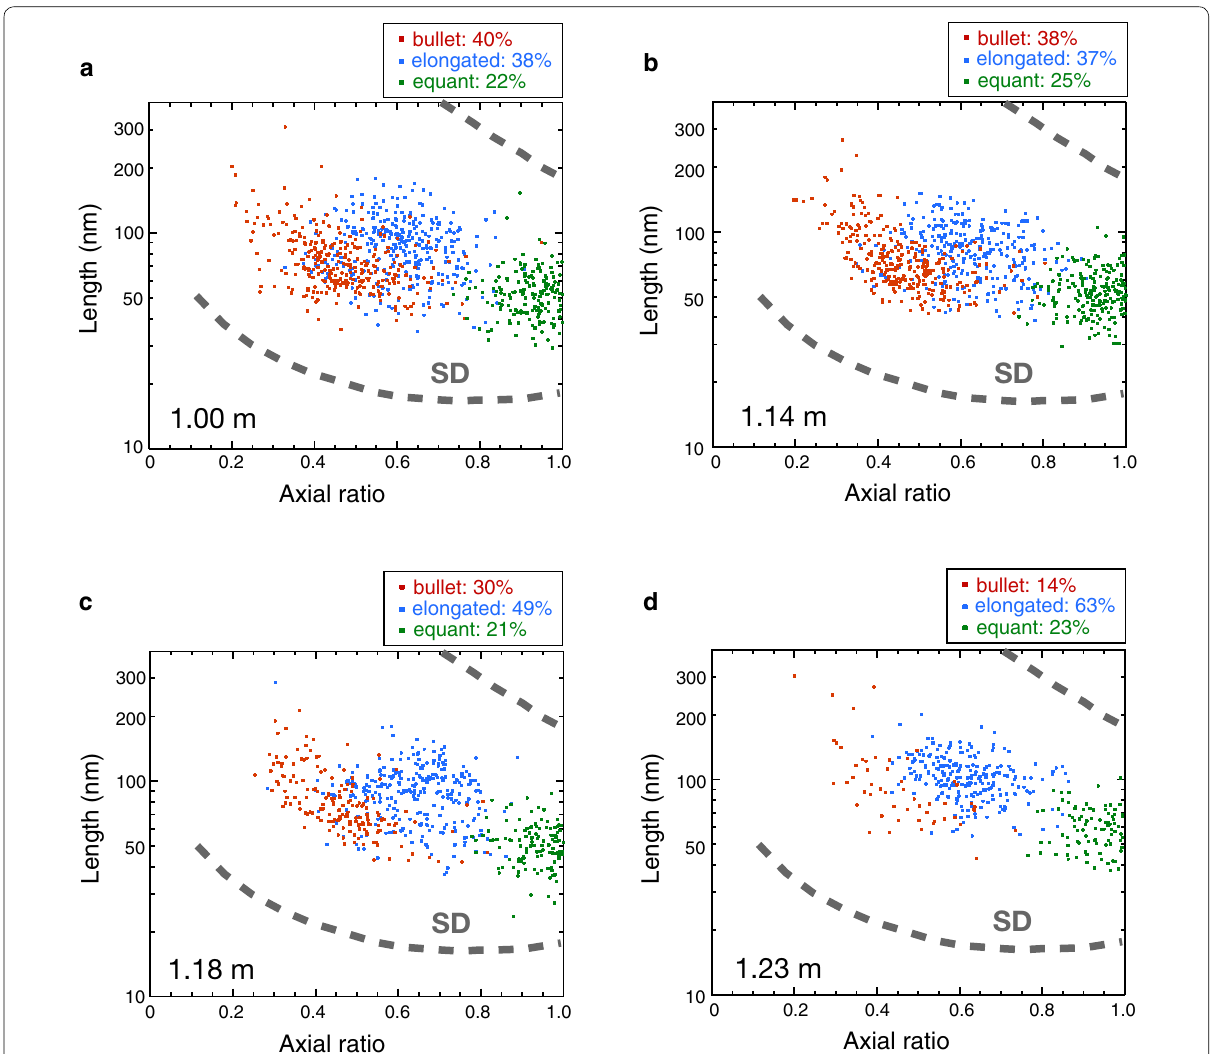
Fig. 5 Morphology and grain size of magnetofossils with respect to magnetic domain state. Samples are depths of a 1.00 m, b 1.14 m, c 1.18 m, and d 1.23 m in the core. Magnetofossils are categorized into the three groups based on their morphology: bullet shaped (red), elongated (blue), and equant (green). Bold dashed curves indicate the maximum single-domain (SD) region for chains of magnetite particles with magnetostatic interactions after Muxworthy and Williams